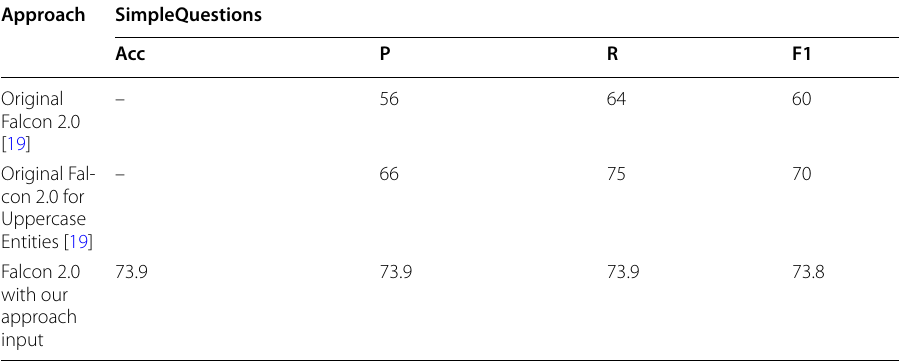
* Used a rule‑based approach, so no training data is used. ** Kuo and Lu’s performance is not comparable as they used a different training dataset than ours Table 8 Model evaluation on entity linking compared with Falcon 2.0 on SimpleQuestions dataset (in